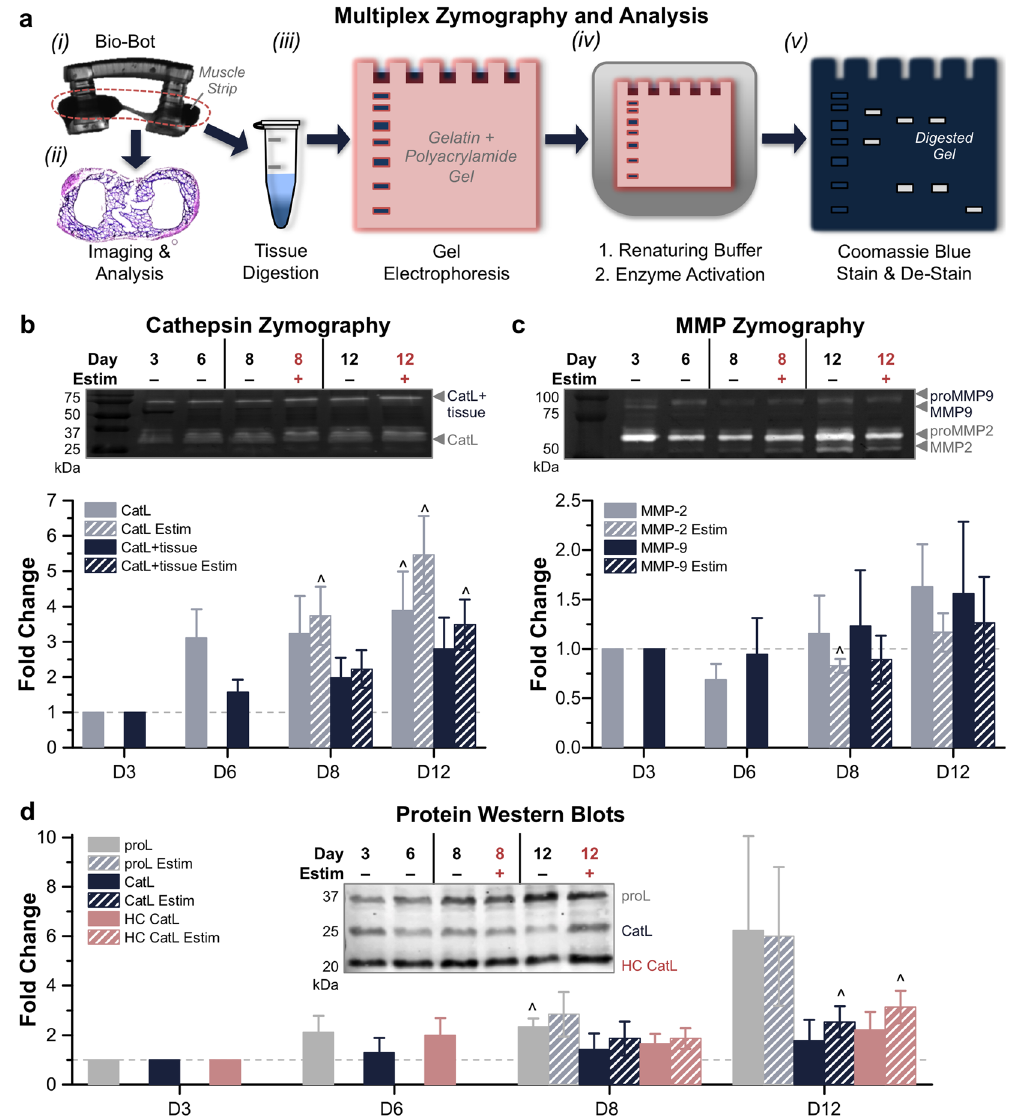
Figure 2. Gelatin Zymography of Cathepsins and MMPs without ACA. ( a ) Muscle strip zymography process flow. (i) Degrading muscle strips were removed from hydrogel skeletons. (ii) Muscle strips could be fixed and stained for further analysis. (iii) Tissues were digested in lysis buffer. Isolated proteins were run through gel electrophoresis. (iv) Gels were incubated in renaturing and assay buffers. (v) Gels were stained with Coomassie Blue; bright bands indicated the activity of specific proteases, which were separated by molecular weight. ( b ) Cathepsin zymography identified the activity of CatL and CatL + tissue at days 3, 6, 8 and 12, in the presence or absence of electrical stimulation ( n = 3–5 muscle strips per condition). ( c ) MMP zymography identified the activity of MMP-2 and MMP-9 at days 3, 6, 8 and 12, in the presence or absence of electrical stimulation ( n = 3–5 muscle strips per condition). For MMP zymograms, upper bands reflect inactive enzyme (proMMP) and lower bands reflect active enzyme. ( d ) Western blotting confirmed the presence of cathepsins and related proteins, such as CysC ( n = 3–5 muscle strips per condition). All plots represent mean ± SEM. ^ indicates significance ( p < 0.05) compared to initial time